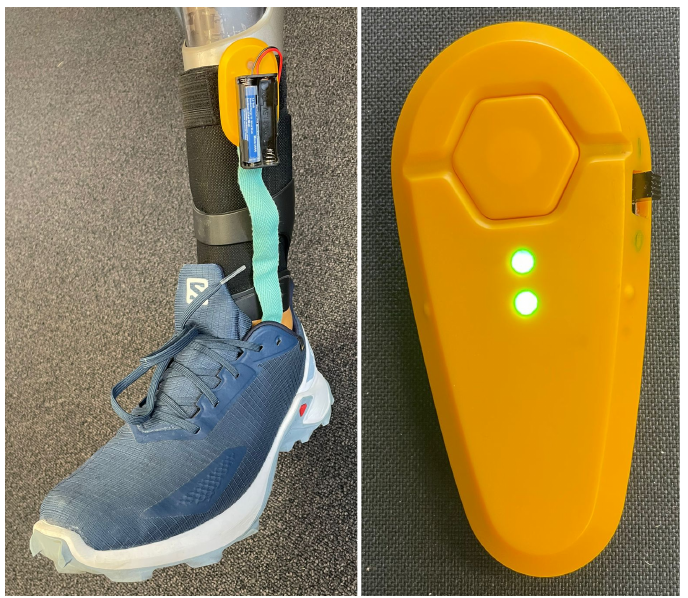
Figure 1. The Suralis sensor systems: The sensor sock worn on a prosthesis within a shoe including the transmitter unit ( left ). The IMU integrated in a housing together with the transmitter unit ( right ).